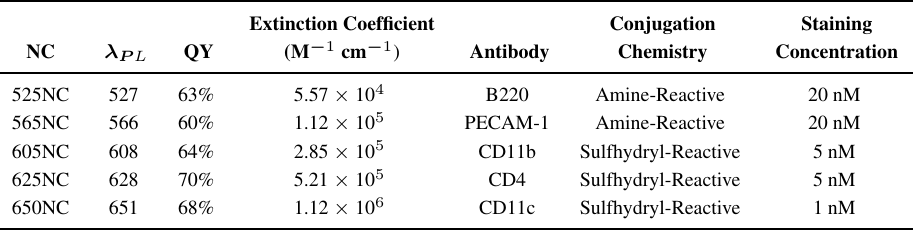
Table 1. Selected optical properties and details of Ab-NC conjugates used in this study. Quantum efficiency measurements were measured relative to either FITC in absolute ethanol (eF525NC) or rhodamine 6G in absolute ethanol. Extinction coefficients listed are relative to the wavelength for the first exciton absorption feature